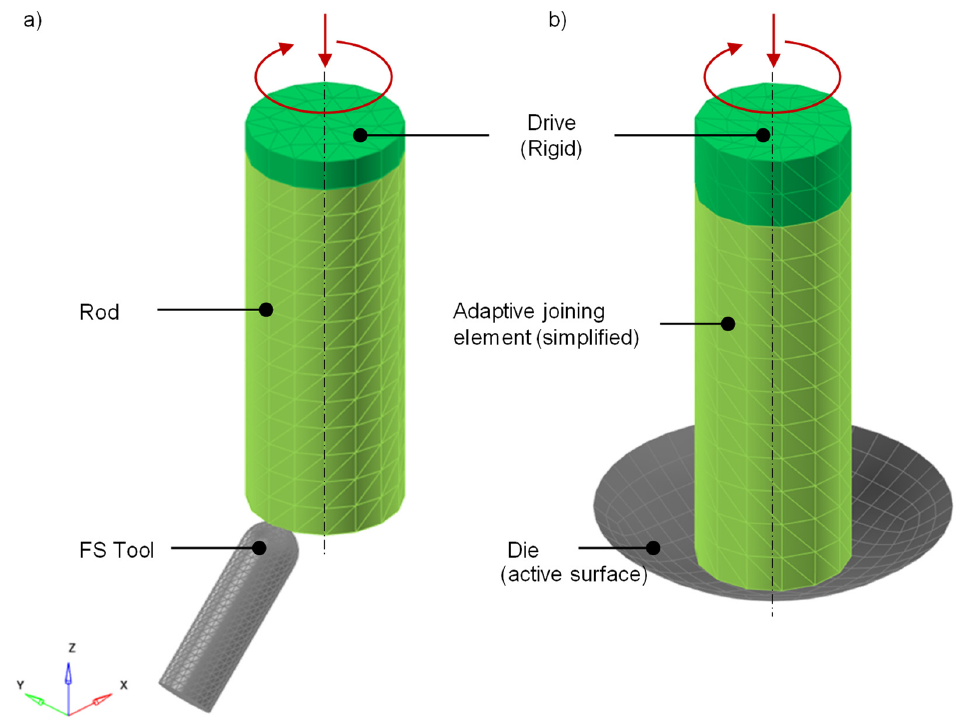
Figure 3. Initial FE modeling of the adaptive joining technology using reduced process step models for ( a ) the forming of the adaptive joining element, and ( b ) the joining process.